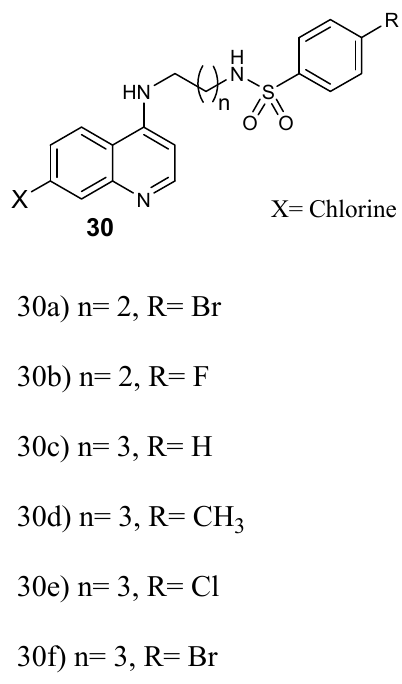
Figure 14. Structure of quinoline–sulfonamide hybrids 30a–f.